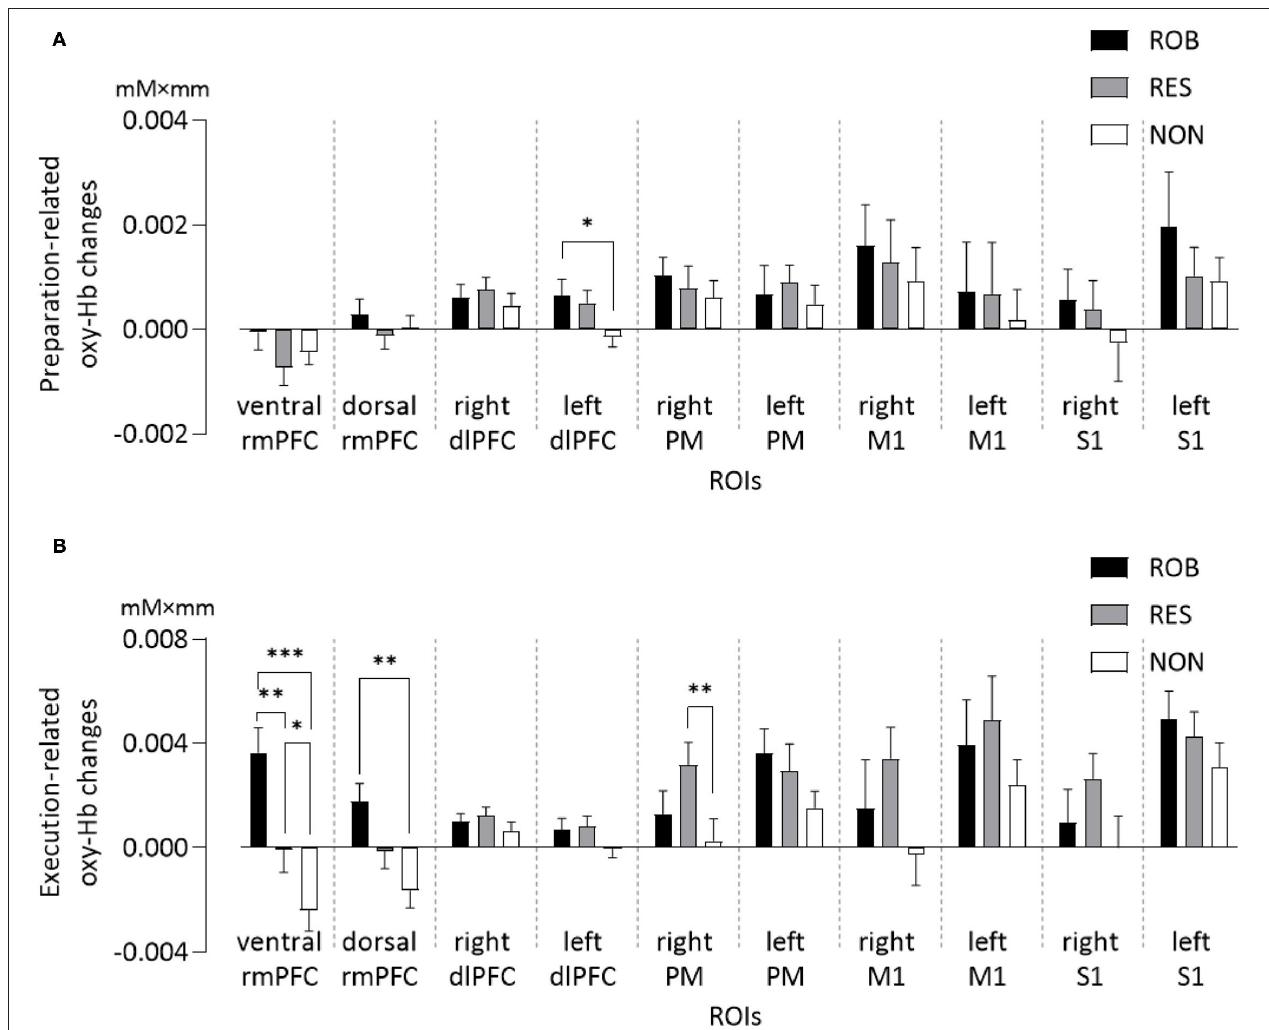
FIGURE 4 | Average changes in oxy-Hb concentration of ROIs for three conditions. Comparisons of (A) preparation-related, and (B) execution-related oxy-Hb changes of ROIs for ROB, RES, and NON. oxy-Hb, oxy-hemoglobin; ROIs, regions of interest; rmPFC, rostromedial prefrontal cortex; dlPFC, dorsolateral prefrontal cortex; PM, premotor area; M1, primary motor cortex; S1, primary somatosensory cortex. * p < 0.05, ** p < 0.01, *** p < 0.001. Data are expressed as the mean with standard error